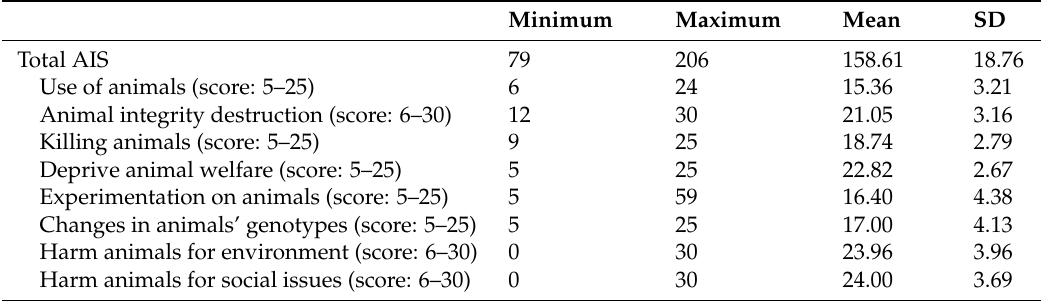
Table 1. Descriptive statistics: total Animal Issue Scale (AIS) and individual variables mean scores.